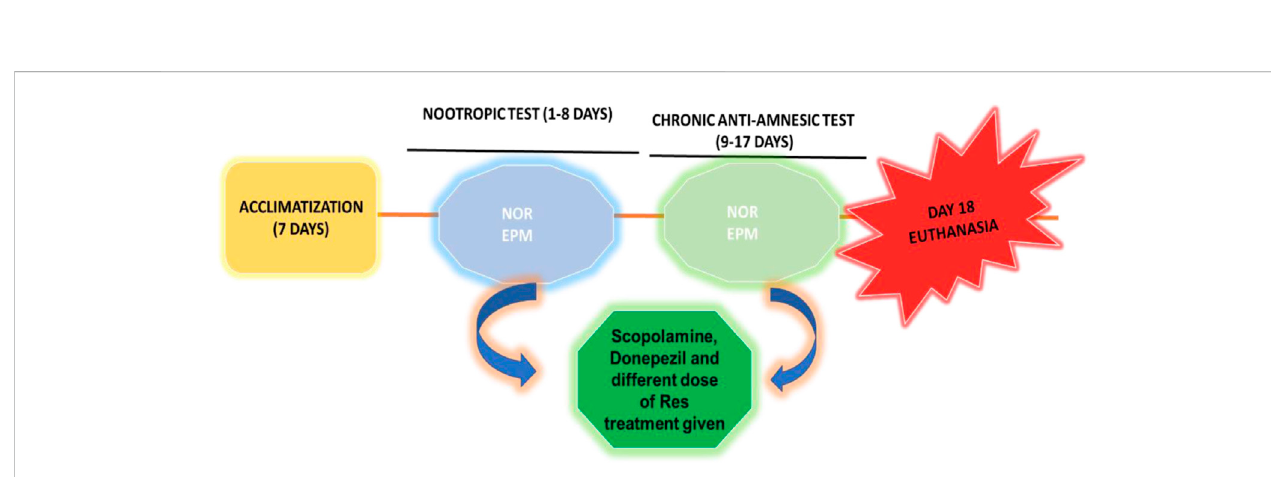
SCHEME 1 Work fl ow diagram of the experimental